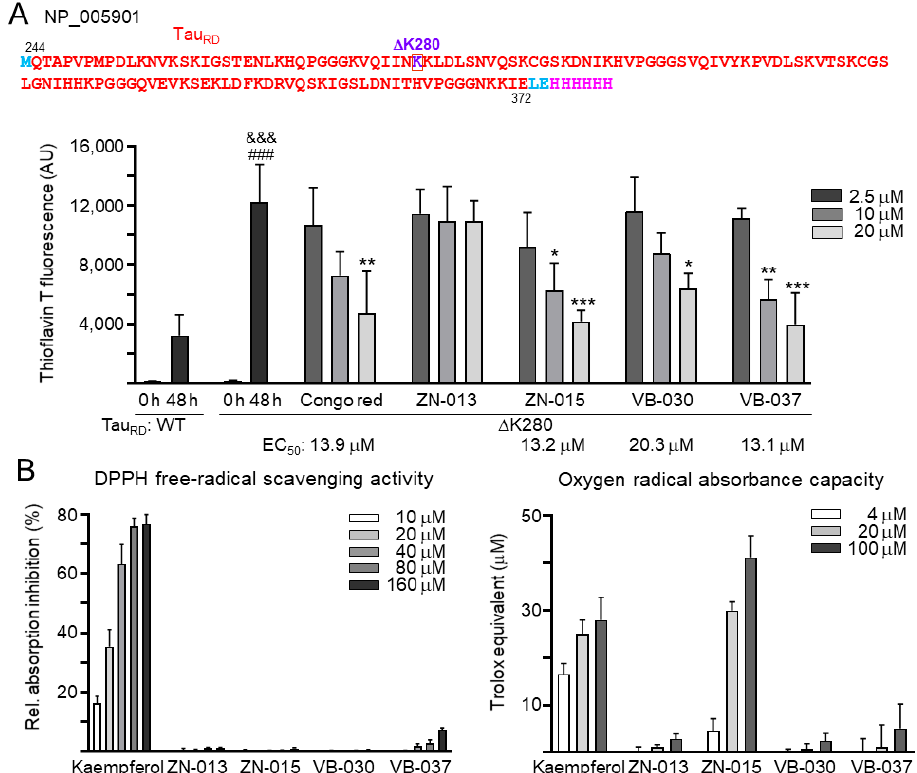
Figure 3. Chemical chaperone and antioxidant activities of ZN/VB compounds. ( A ) Thioflavin T binding assay for Tau RD (Q 244 -E 372 of Tau, NP_005901) aggregation. Top: Amino acid sequence of Tau RD -His protein, with Tau RD marked in red, ∆ K280 marked in purple, in-frame-fused His 6 marked in pink, and N-terminal Met and linker (Leu and Glu) marked in blue. Bottom: Anti-aggregation assay. Tau RD protein (20 μ M) was incubated with congo red, ZN-013, ZN-015, VB-030 or VB-037 (2.5–20 μ M) at 37°C for 48 h, and aggregation was monitored by measuring thioflavin T fluorescence intensity ( n = 3). p values: comparisons between 0 h and 48 h ( ### : p < 0.001), wild type versus Δ K280 ( &&& : p < 0.001), or with and without compound addition (*: p < 0.05, **: p < 0.01, ***: p < 0.001) (one-way ANOVA with a post hoc Tukey test). ( B ) Antioxidant assays of kaempferol (as a positive control) and ZN/VB compounds (10–160 μ M for DPPH free radical scavenging activity and 4–100 μ M for trolox equivalent oxygen radical absorbance capacity) ( n = 3).